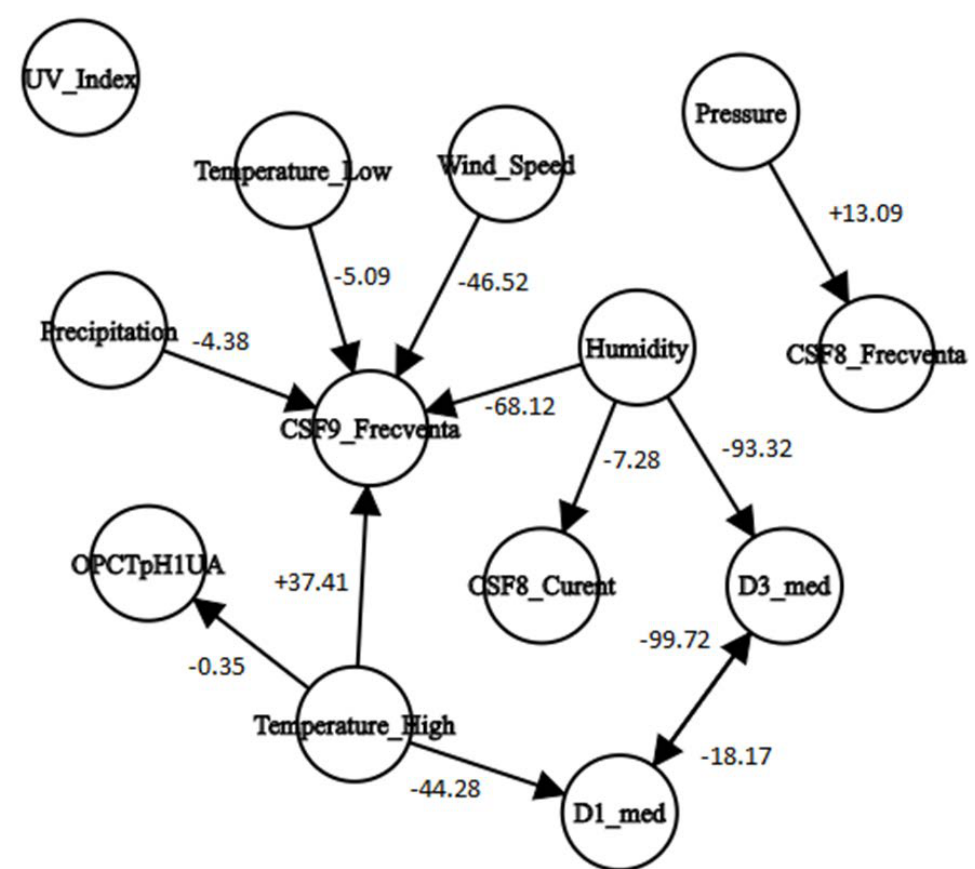
Figure 8. The dependencies graph for test case 7.